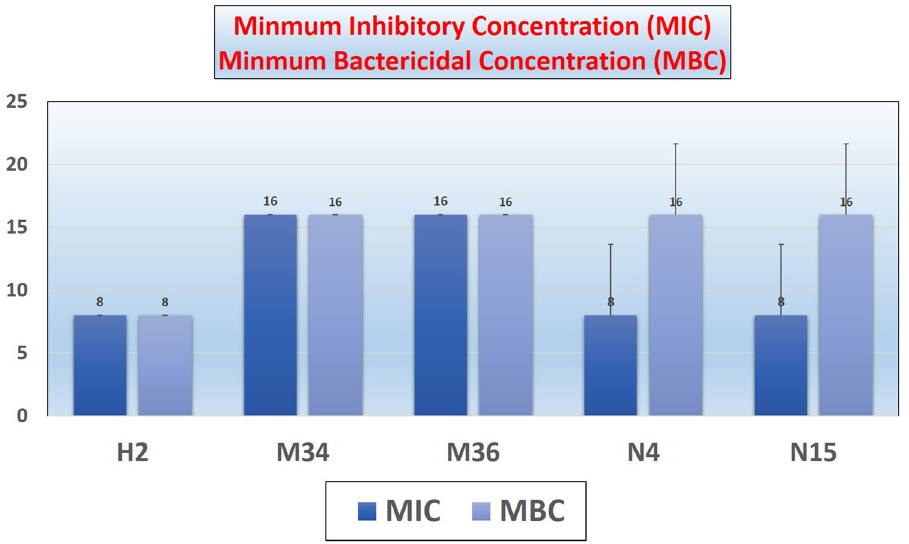
Figure 2. MIC was determined by micro-broth dilution technique and values (Mean) obtained in triplicate for both MIC and MBC.